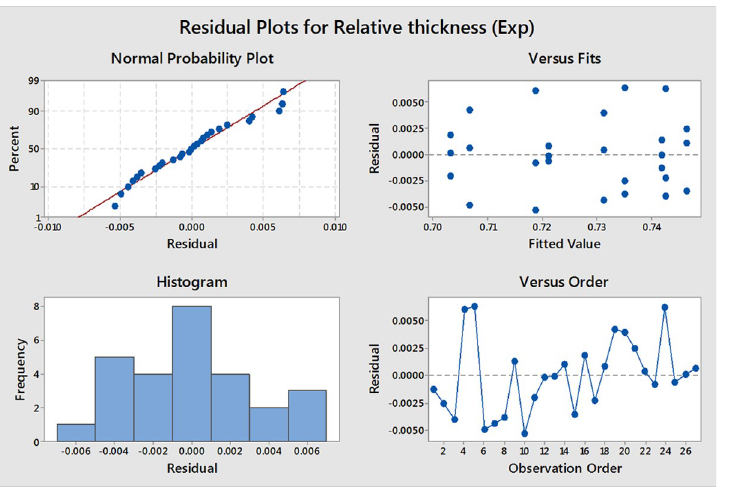
Fig 17. Residual plots RT.